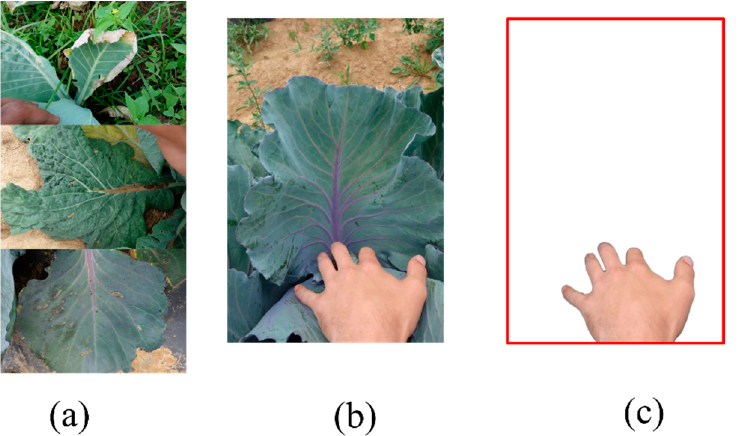
Figure 2. Images with an undesired background. ( a ) Leaf image in situ, the top image contains a leaf from another species on top of the region of interest; the bottom two contain mud on top of the healthy leaf, appearing to be diseased; ( b ) image with the human hand in the foreground; ( c ) segmentation result of the image on the left.